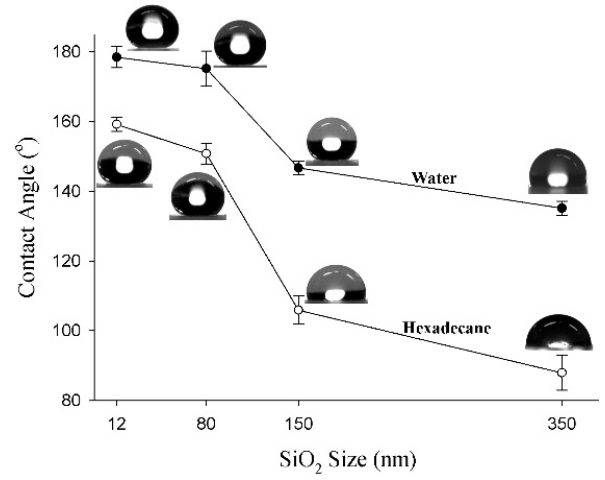
Figure 8. Water and hexadecane contact angles as a function of core SiO 2 size.